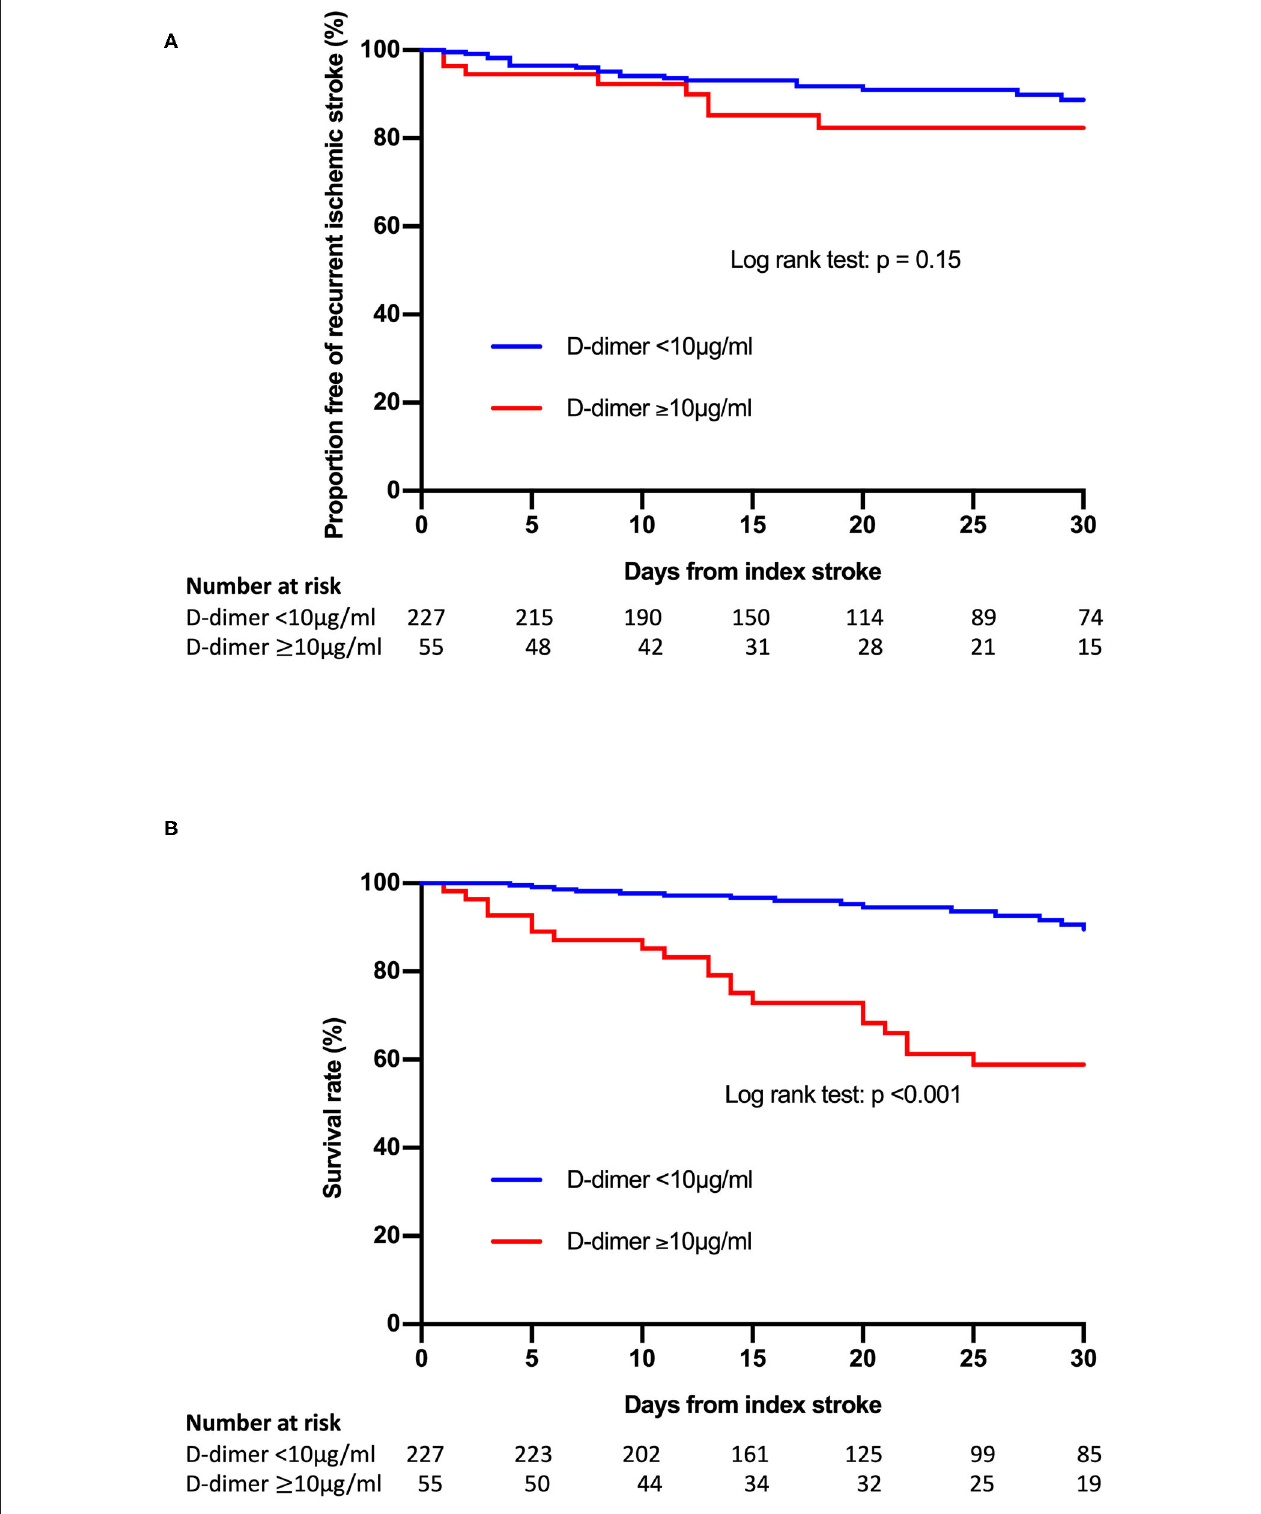
FIGURE 1 | Kaplan-Meier curves of freedom from recurrence of ischemic stroke events (A) and survival (B) according to the post-treatment plasma D-dimer level.